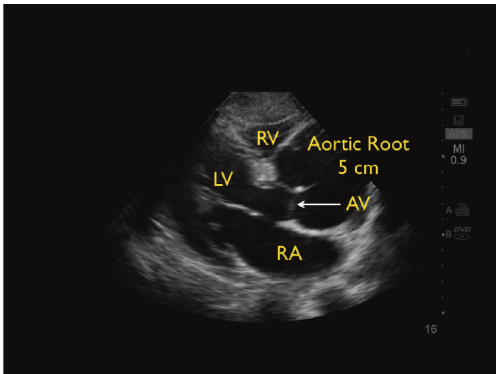
Figure 26: Aortic arch dissection with widened aortic root, parasternal long axis view. RV: right ventricle, LV: left ventricle, LA: left atrium, AV: aortic valve.